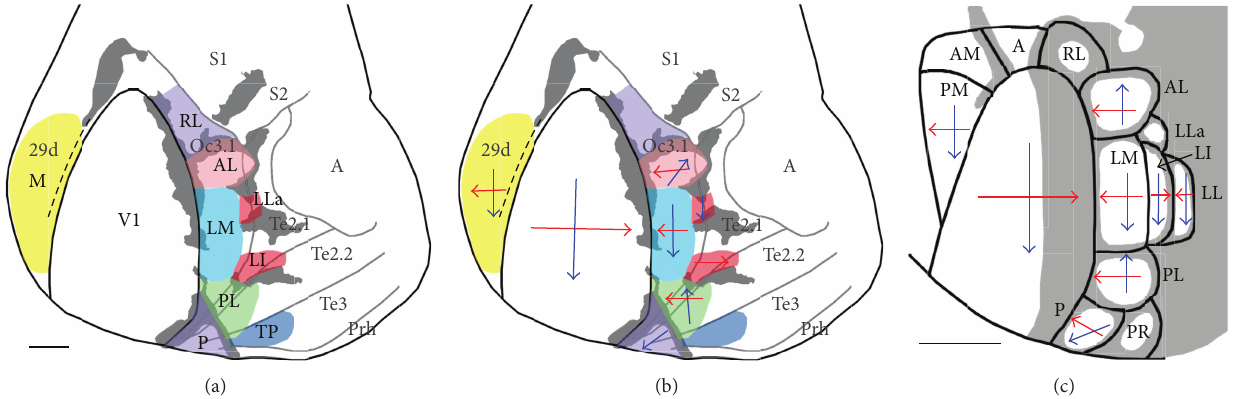
Figure 9: Tentative diagram of rabbit visual areas and topography derived from present study, and comparison with the rat. ((a) and (b)) The callosal pattern (grey) is based on case 86-21 (Figure 5). (a) Location and name of putative visual areas. M: medial area. (b) Approximate representations in extrastriate areas of the mediolateral (red arrows) and anteroposterior (blue arrows) axes in V1. Lack of arrows indicates insufficient data. (c) Diagram of rat visual areas based on physiological and anatomical studies [1–6, 9–12, 16, 36, 39, 47, 70]. Callosal pattern is represented in grey. A: anterior area, AM: anteromedial area, PM: posteromedial area, and PR: pararhinal area. Scale bars = 2